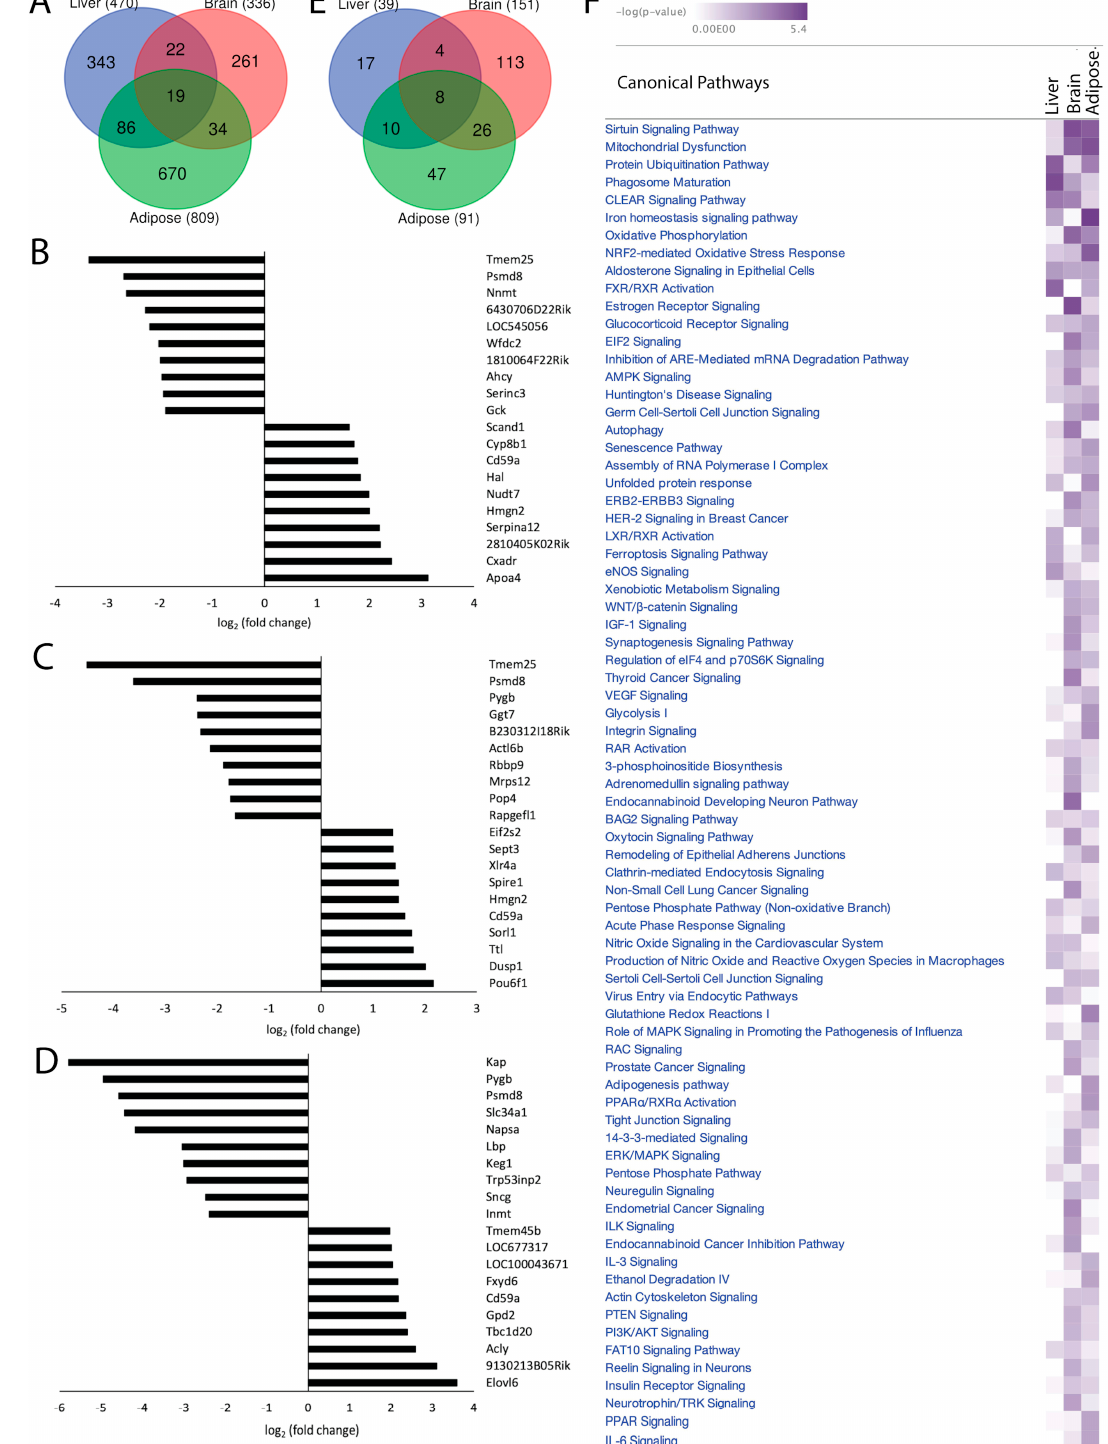
Figure 2. Acss2 loss institutes tissue-specific changes in the transcriptome and canonical signaling pathways in mouse liver, brain and adipose tissue. DEGs were determined in Acss2 − / − mice, as compared with wild-type control groups, in three metabolically disparate organ systems